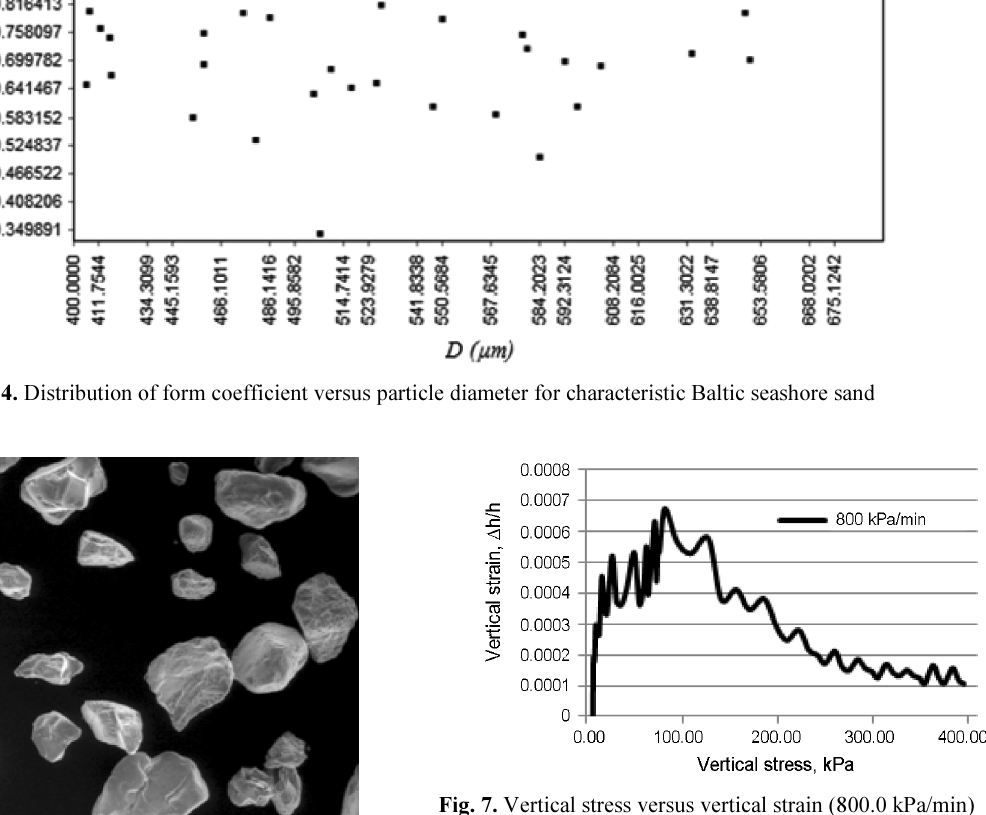
Fig. 7. Vertical stress versus vertical strain (800.0 kPa/min) Analyzing the results of Fig. 7 it was observed that when vertical stress is less than 200 kPa, vertical strain values increase. When vertical stress is between 200 and 400 kPa, vertical strain values stabilize and vertical stress ramp becomes equal to theoretical. This process depends on initial soil sample void ratio. Vertical strain values increase when soil sample void ratio is high. When soil density increases, then vertical strain values decrease. The direction line, created according to loading ve- locity and load application time, shows that loading velo- city was not linear (Fig. 8). In case of homogeonous ma- terial the direction line corresponds to the horizontal one.